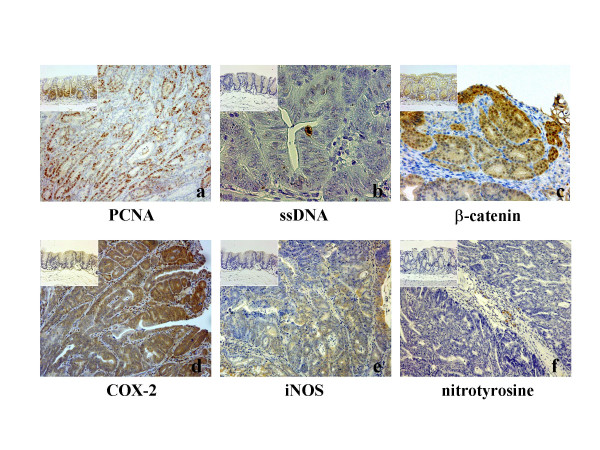
Immunohistochemistry of PCNA, ssDNA, β-catenin COX-2, iNOS, and nitrotyrosine in mice of group 1. (a) PCNA immunohistochemistry, (b) ssDNA immunohistochemistry, (c) β-catenin immunohistochemistry, (d) COX-2 immunohistochemistry, (e) iNOS immunohistochemistry, and (f) nitrotyrosine immunohistochemistry. Original magnifications: a, d, e, f, × 10; c, × 20; b, × 40. Insets, immunohistochemistry staining for each antibody in the mouse colon from group 10 (Original magnifications, × 10).